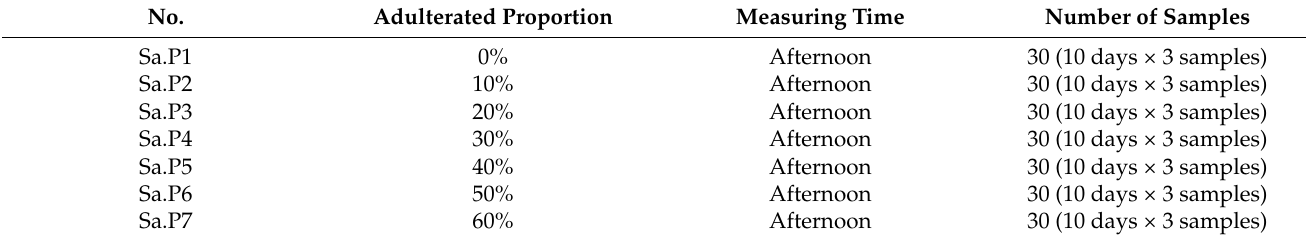
Table 2. Details of the meat samples in Measurement B.